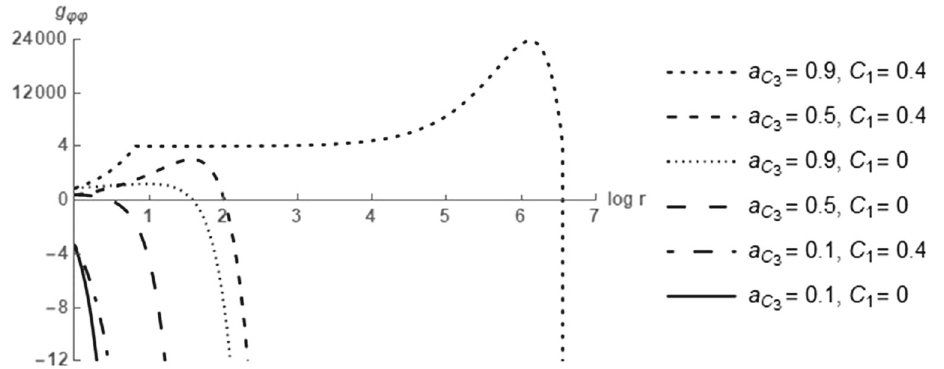
Fig. 1 Behavior of g ϕϕ for distinct a C and C 1 values, with C 4 = 0 . 1, C 5 = 1, C a = 0 . 08, r min = 1 and M = M − . When g ϕϕ > 4 the adopted 3 scale for the vertical axis is different from that when g ϕϕ ≤